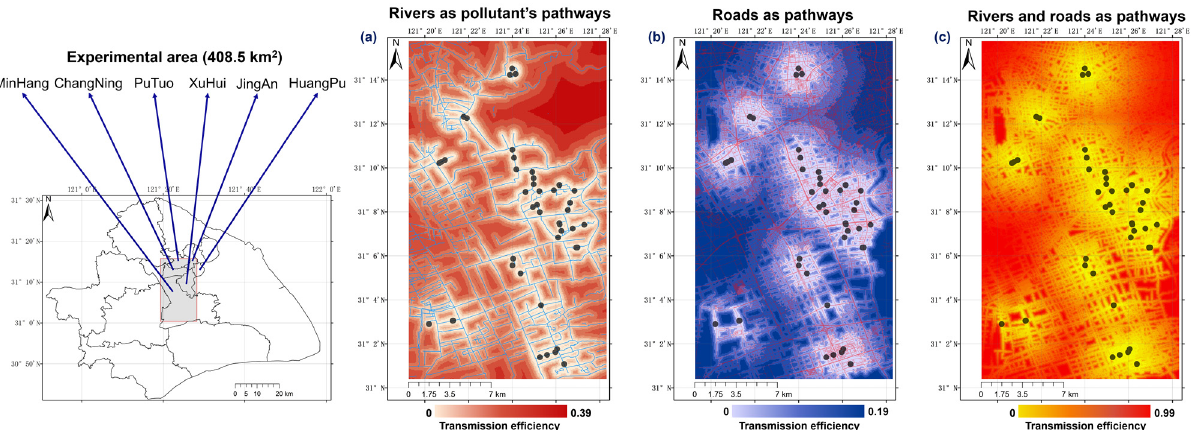
Figure 6. Cost distance analysis of the spatial extents that potential pollutants may affect the water quality of the sampled cross-sections by river and road networks in the experimental area of central Shanghai. Black circles are sampled cross sections in this experimental area. ( a , b ) considered the single effect of rivers or roads. ( c ) considered combined effects of rivers and roads, where the transmission efficiency of the pollutants by rivers and roads are weighted as 1 and 0.5, respectively.